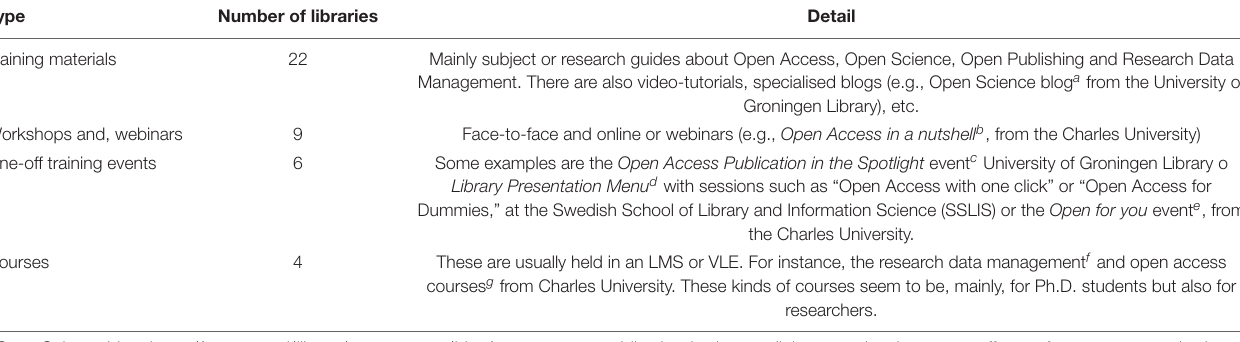
TABLE 6 | Capacity-building programmes in academic